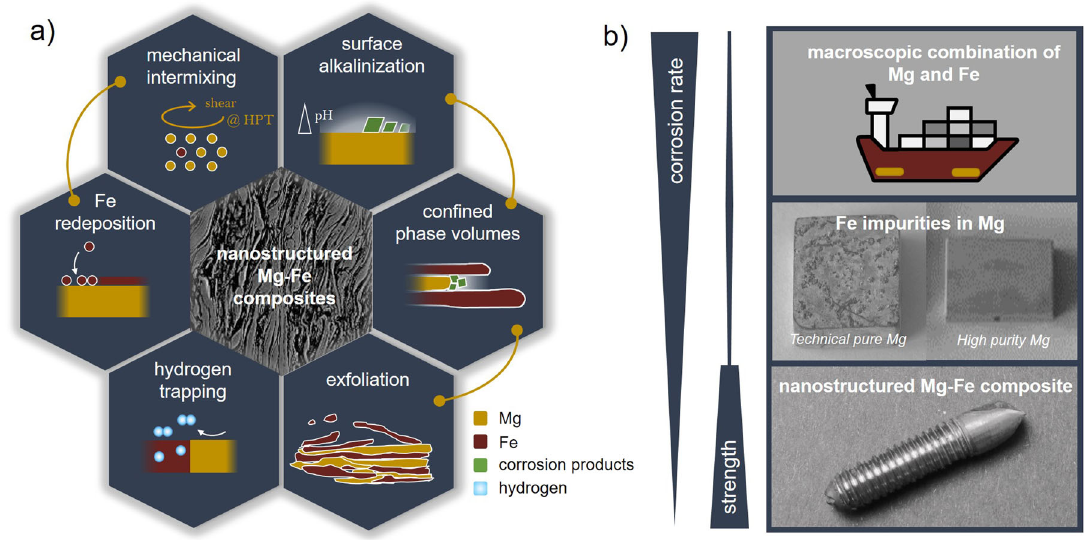
Fig. 3 Processes controlling the corrosion behavior of nanostructured Mg – Fe composites and material properties of Mg – Fe combinations at different length scales. a Schematic of discussed corrosion processes active for the nanostructured Mg ‒ Fe composite. b Left: Property space of Mg and Fe combinations at different length scales (from macroscopic at the top to nanostructured at the bottom) and, right: their technological use. Top: Mg ’ s low corrosion resistance is used as sacri fi cial anodes in shipbuilding or offshore protection. Center: microscopic Fe particles in Mg as impurities do not have any technological use but are detrimental to Mg ’ s corrosion resistance. Technical pure Mg corrodes signi fi cantly faster than high purity Mg (photographs after 2 h in 0.15 M NaCl). Bottom: nanostructured Mg – Fe composites have low corrosion rate and high mechanical strength. Photograph is a screw fabricated from the nanostructured Mg – Fe composite, intended to be used in orthopedics and